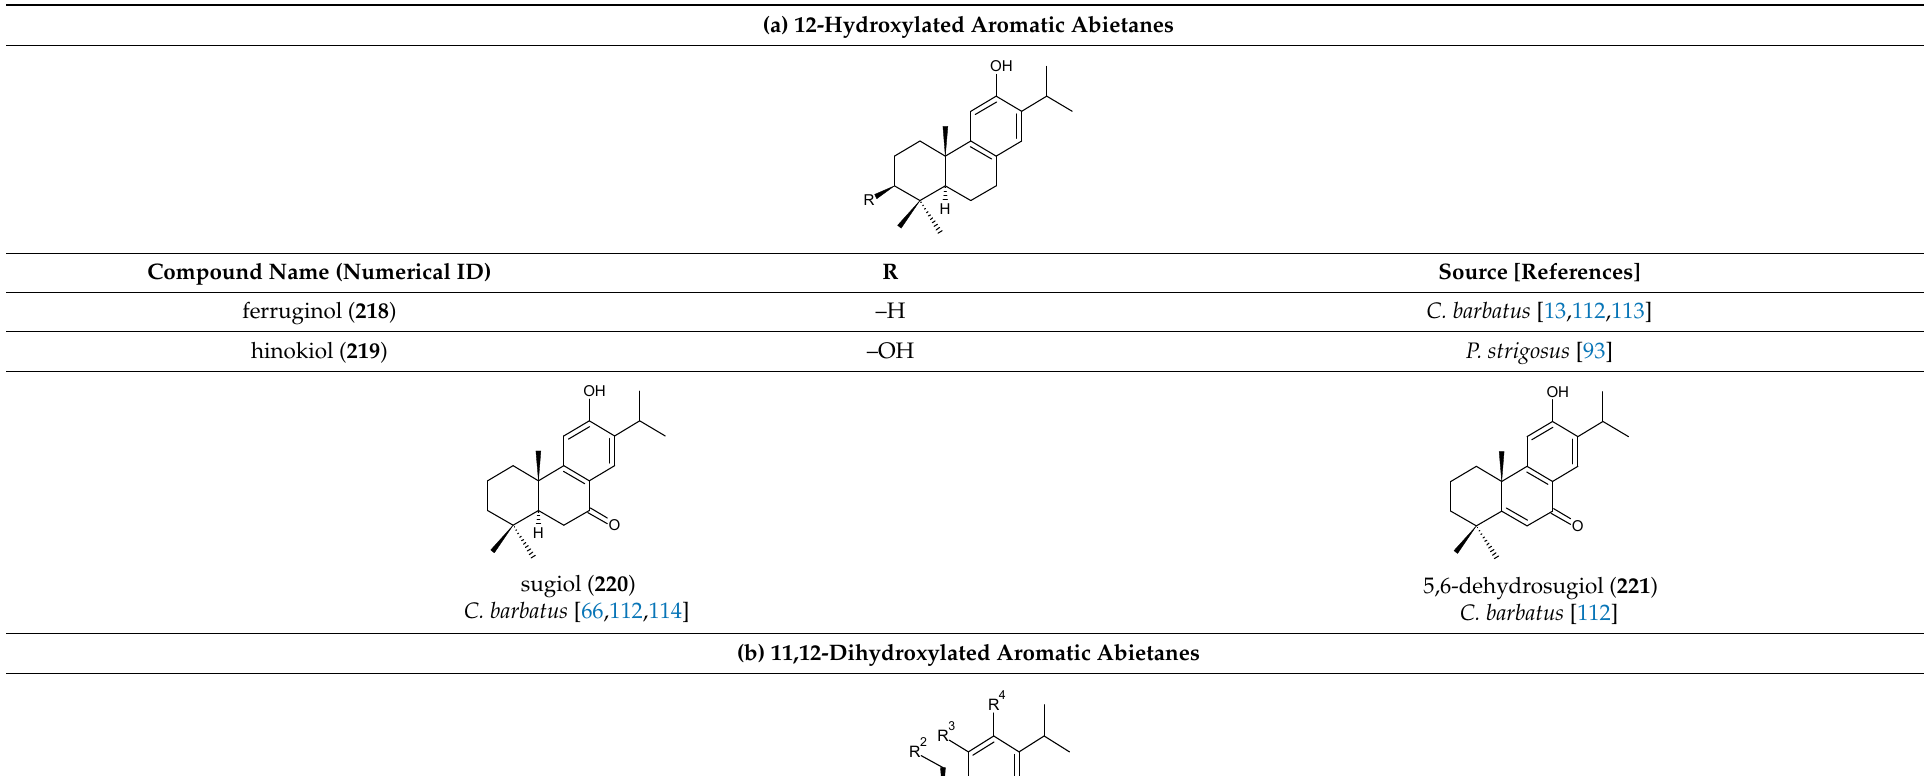
Table 8. Other phenolic abietanes of the genus Plectranthus s.l.